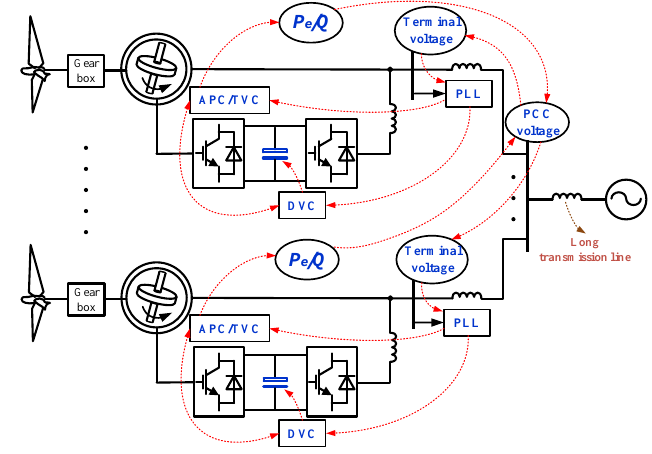
Figure 2. Diagram of multi DFIGs interactions in the DC-link voltage control timescale.